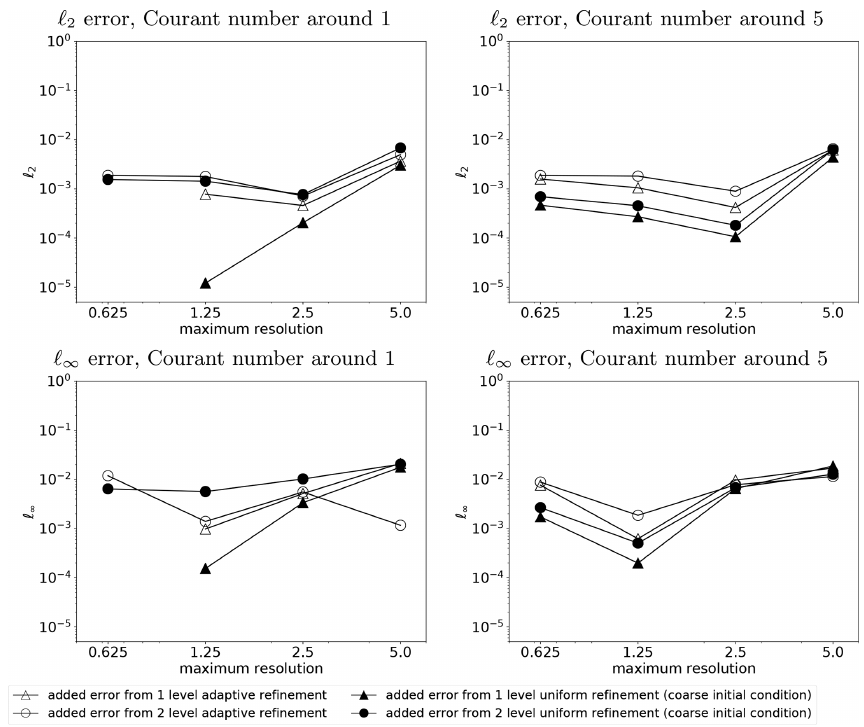
Figure 20. Differences of numerical errors between non-adaptive meshes using exact initial conditions and exact wind fields and adaptive or uniformly refined mesh using a coarse initial condition and interpolated wind field in the moving vortices test